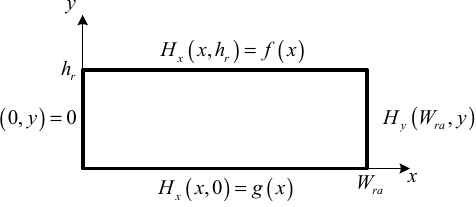
Figure 9. Boundary condition of the magnetic field intensity of the rotor slots.